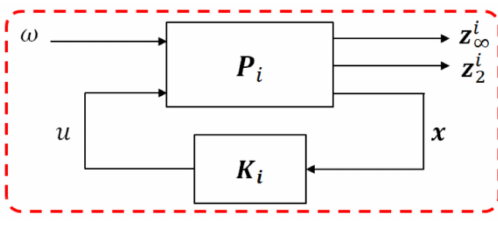
Figure 4. State feedback